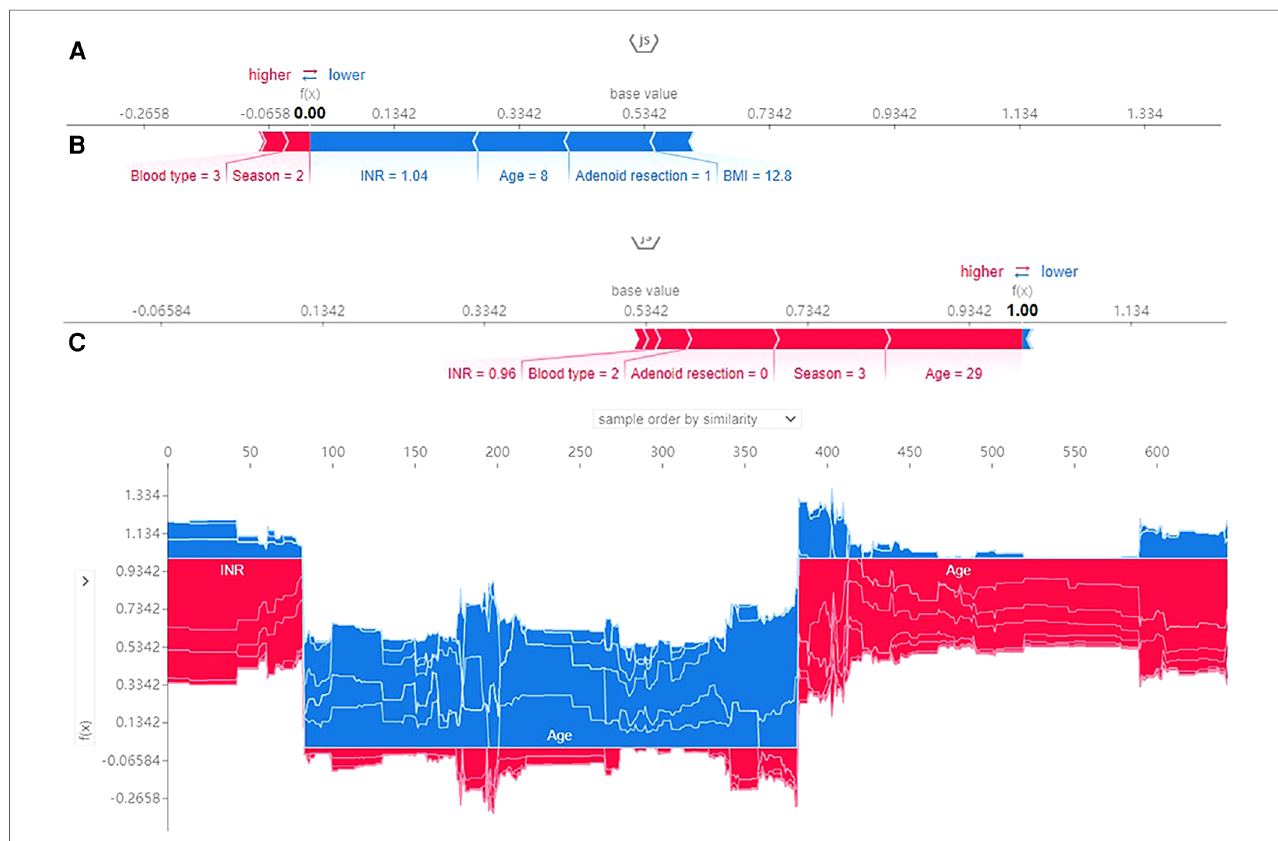
FIGURE 6 SHAP force plot for patients in the dataset at high ( A ) or low ( B ) risk of PTH; 1, 2, 3 and 4 represents spring, summer, autumn, winter and blood type A, B, O, AB; ( C ) SHAP values (global interpretation) for the training set. The abscissa represents each patient, and the ordinate represents the SHAP